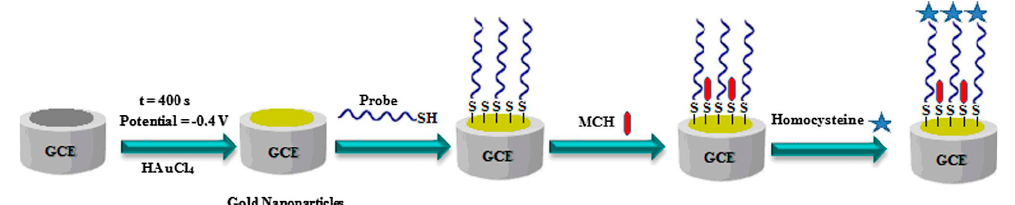
Figure 2. Electrochemical aptasensor for detection of homocysteine in blood serum and urine. A glassy carbon electrode is coated with AuNPs, which in turn are functionalized with SH-aptamers. The aptamers selectively bind to homocysteine leading to increased voltametric and current values. Image adapted from [25] with permission of Elsevier,